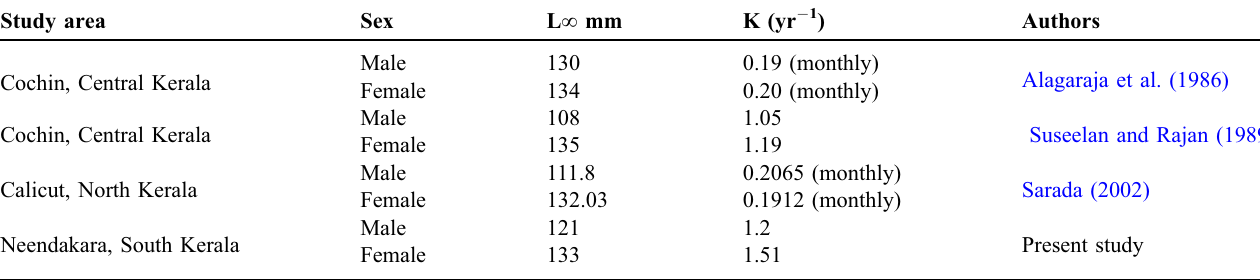
Table 1. Comparison of growth parameters of P. stylifera between previous and present studies. Study